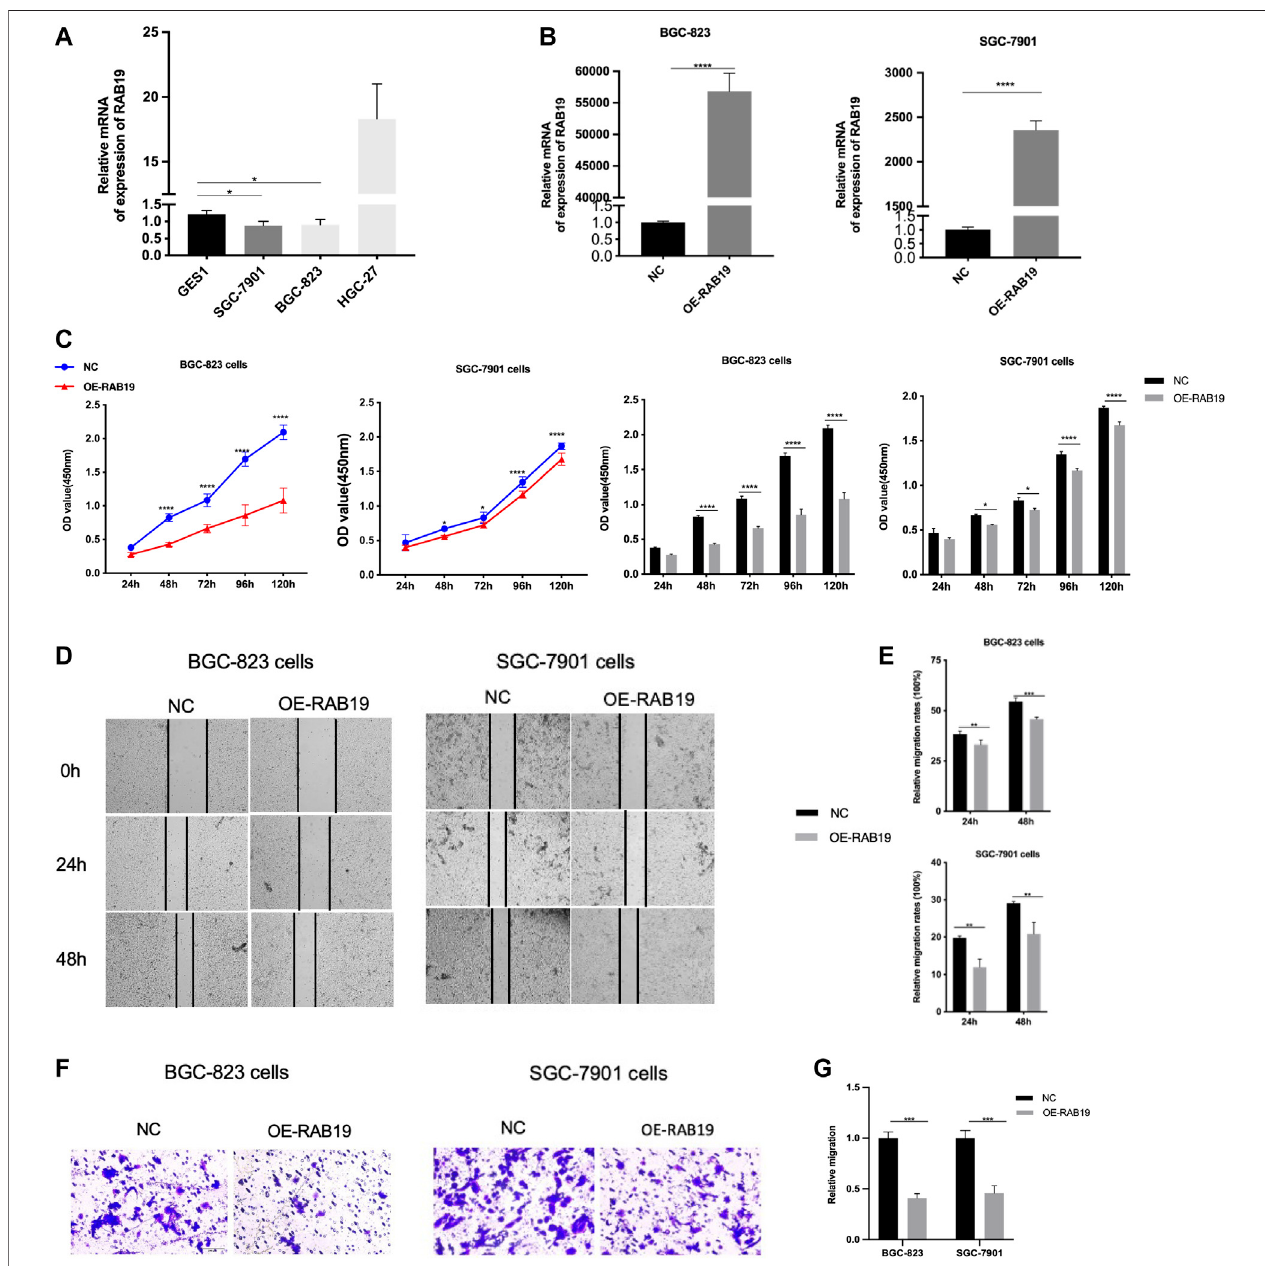
FIGURE 10 | Overexpression of RAB19 inhibits migration and proliferation, in gastric tumor cells (A) In the STAD cell lines, SGC-7901, BGC-823, HGC-27, and normal gastric epithelial cell line GES1, the relative expression level was detected by RT-PCR (B) In the BGC-823 and SGC-7901 cell lines, the transfection ef fi ciency of OE-RAB19 was detected by RT-PCR (C) In the BGC-823 and SGC-7901 cell lines, the effect of RAB19 overexpression on the proliferation was detected by the CCK-8 assay (D) Representative images from the wound healing assay (E) After overexpression of RAB19, the results of wound-healing assay were analysed (F, G) After overexpression of the RAB19, the transwell assay results were statistical analysed in the BGC-823 and SGC-7901 cell lines. *** p < 0.001, ** p < 0.01, and * p < 0.05.